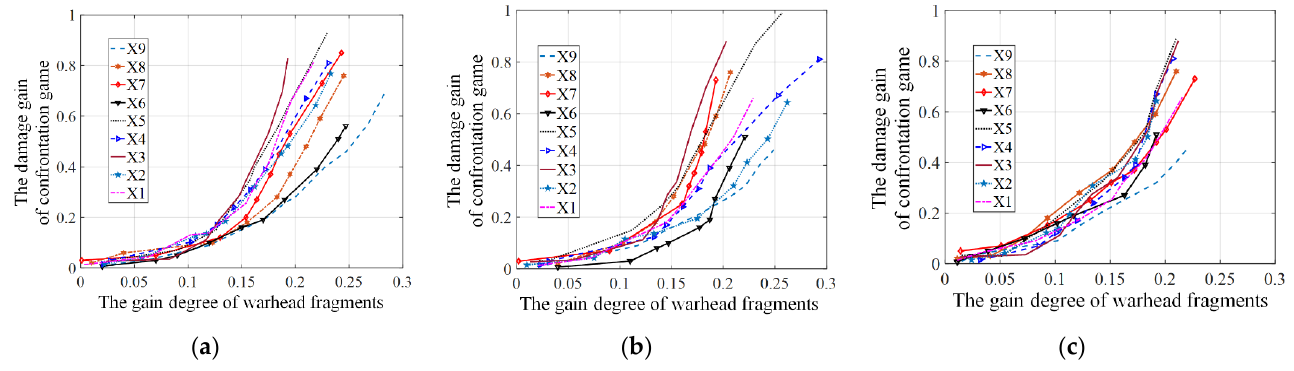
Figure 4. The damage gain of the confrontation game under the different numbers of warhead fragments hitting the aircraft target: ( a ) The damage gain of the confrontation game when the number of warhead fragments hitting the aircraft target is 1500; ( b ) The damage gain of the confrontation game when the number of warhead fragments hitting the aircraft target is 2000; ( c ) The damage gain of the confrontation game when the number of warhead fragments hitting the aircraft target is 2500.